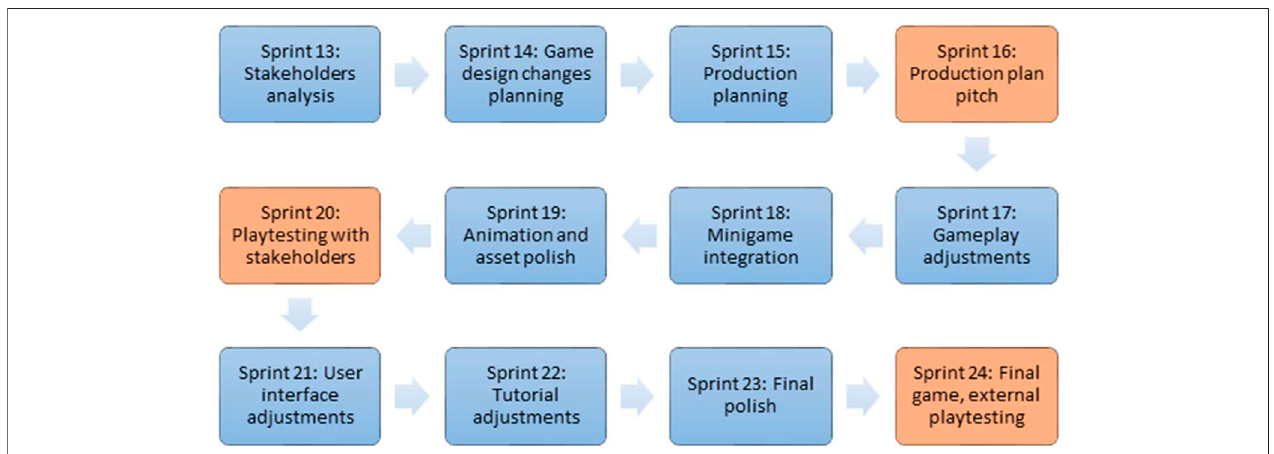
FIGURE 5 | Diagram showing the production phase of game development for this project.